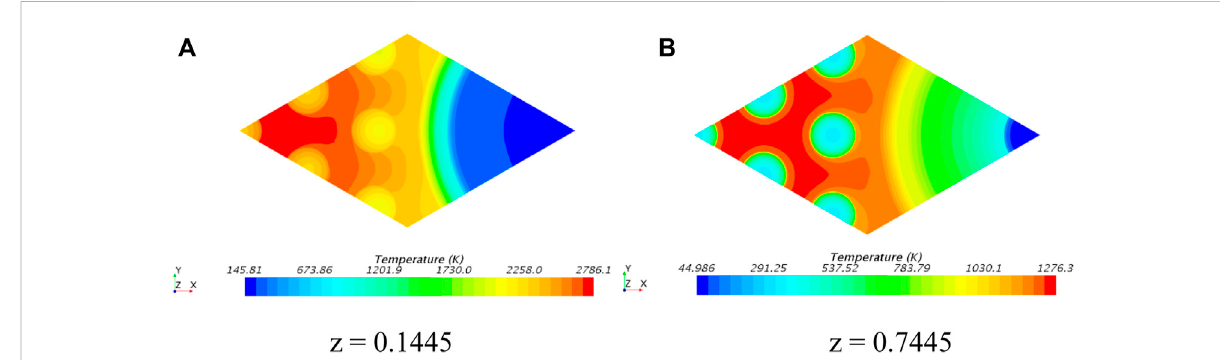
FIGURE 8 Cross-sectional pro fi les of temperature in case 2. (A) cross-sectional pro fi le while height is equal to 0.1445. (B) cross-sectional pro fi le while height is equal to 0.7445.